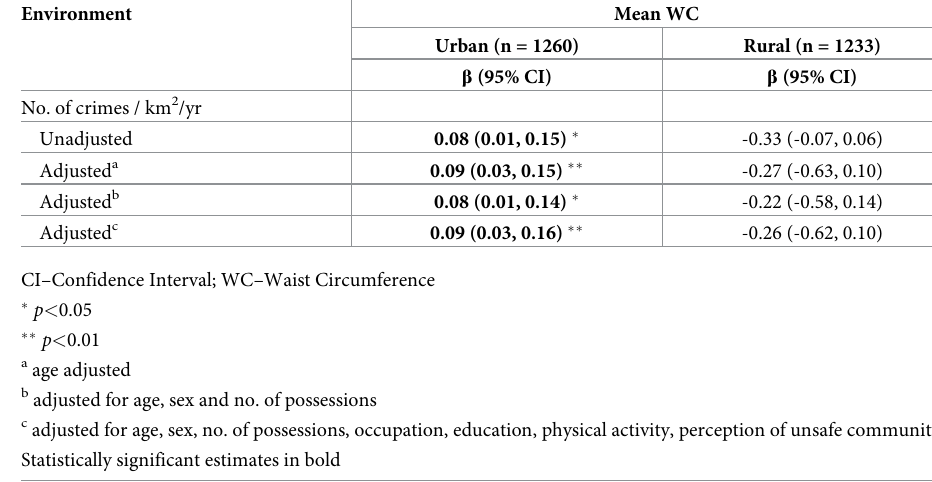
these models. The models were refitted using the square root, reciprocal of the square root and logarithm to the base e transformations of the outcome variables. Each transformation yielded a model that was a substantial improvement on the model produced by the original (untrans- formed) data as the reduction in AIC was larger than 10 [54], although not all the residuals from the refitted models had a normal distribution. The conclusions drawn from the use of transformed data remained the same as for models that used untransformed data.